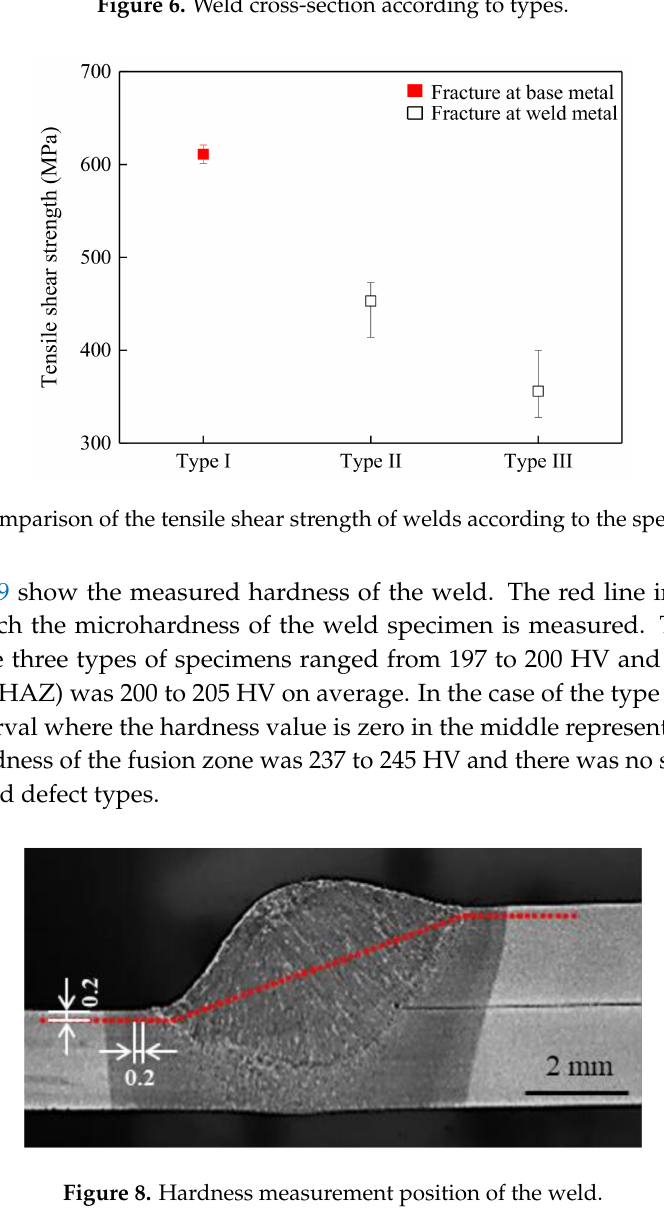
Figure 6. Weld cross-section according to types.